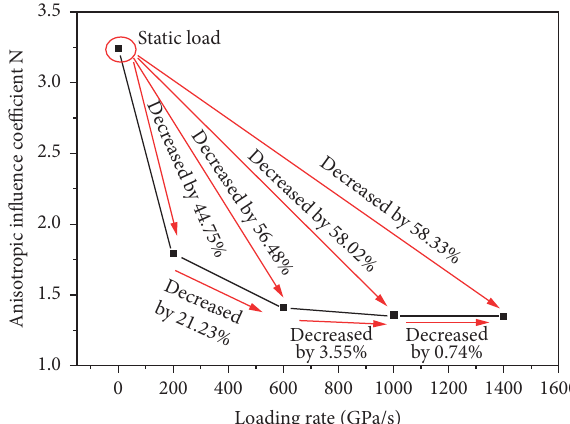
Figure 13: The relationship between the anisotropic influence coefficient N and the loading